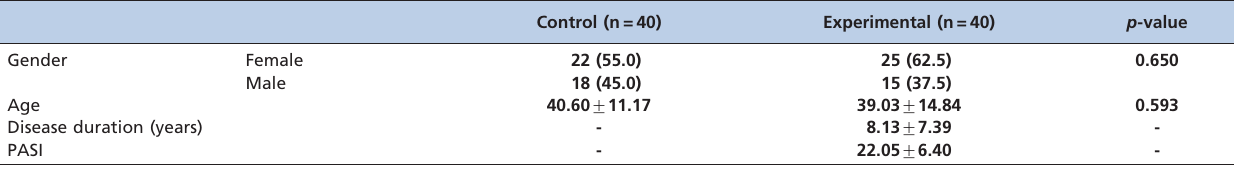
Table 1 - Demographic data of patients in the experimental and control groups.